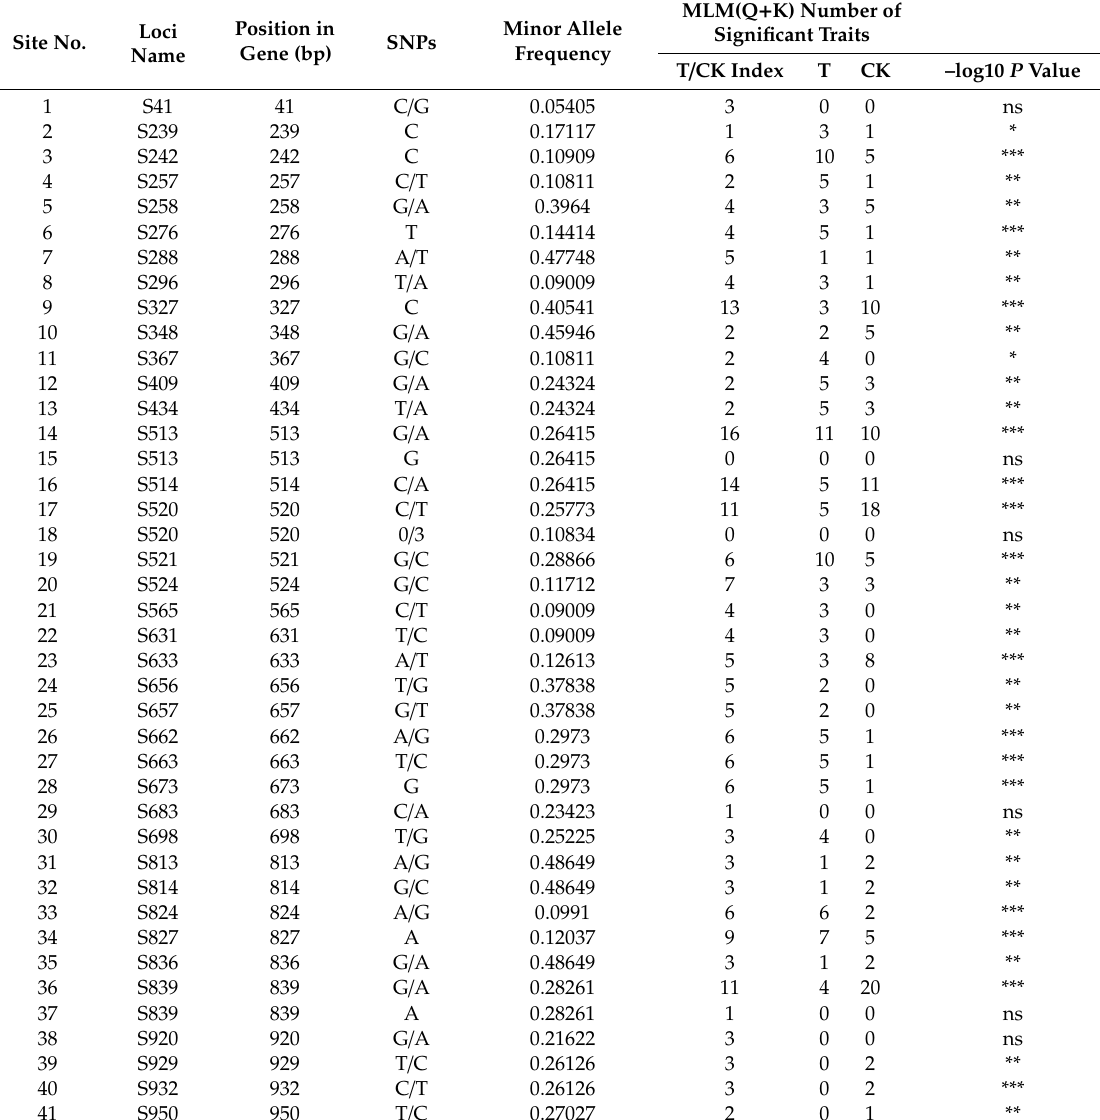
Table 3. Statistics of association analysis between the polymorphisms in ZmNAC9 and low-P tolerance traits in maize